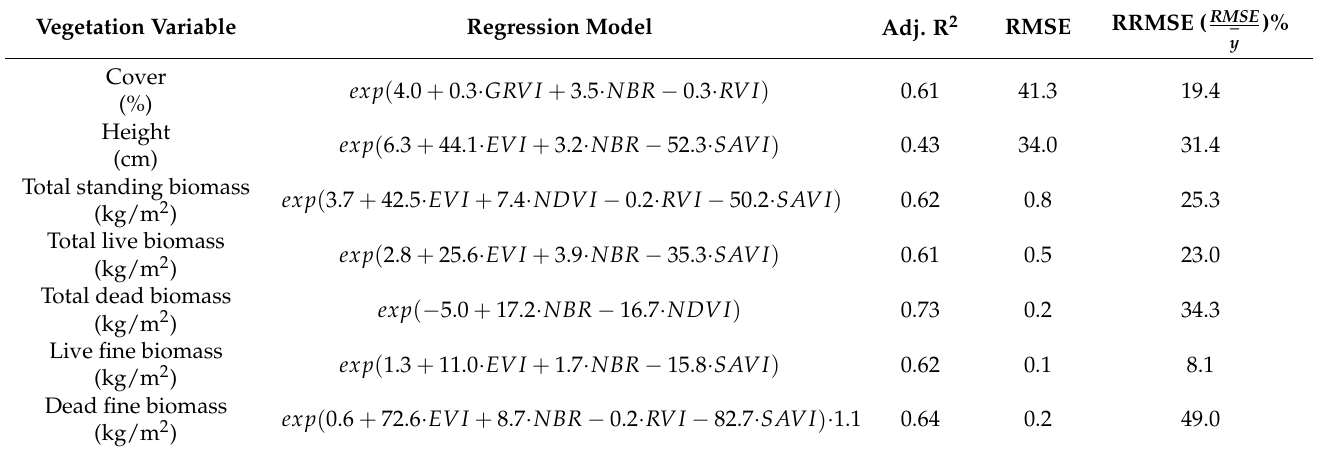
Table 7. Summary of best regression models and the corresponding statistical metrics (Adjusted R 2 , RMSE and RRMSE) determined for each vegetation variable using Sentinel-2 spectral indices. The RMSE units are the same as those of the dependent